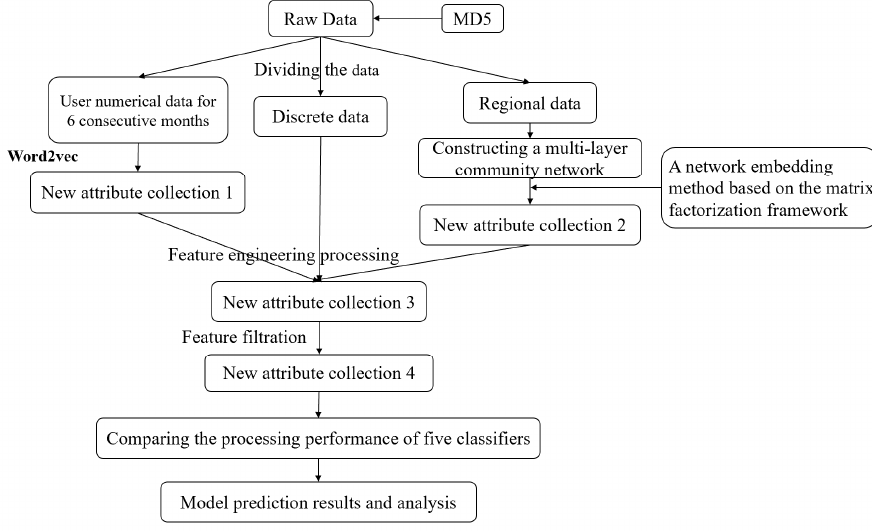
Figure 1. Modeling